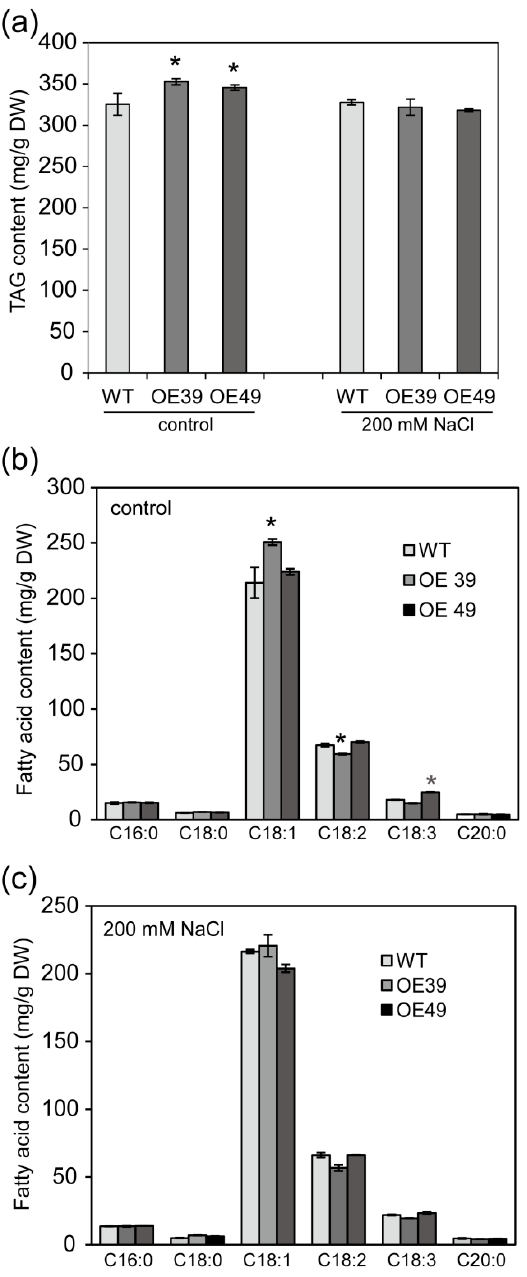
Figure 6. BnWIN1 enhanced seeds oil accumulation. ( a ) Oil (TAG) content of seeds. ( b , c ) Fatty acid compositions of seeds. Forty-day-old plants grown in soil in pots were treated without (control) or with 200 mM NaCl for 30 days, and seeds were collected from plants at the mature stage. Seed oil was analyzed by GC after methylation. Values are mean ± SD ( n = 4 separate samples). * denote significance at p < 0.05 compared with WT plants based on Student’s t test.